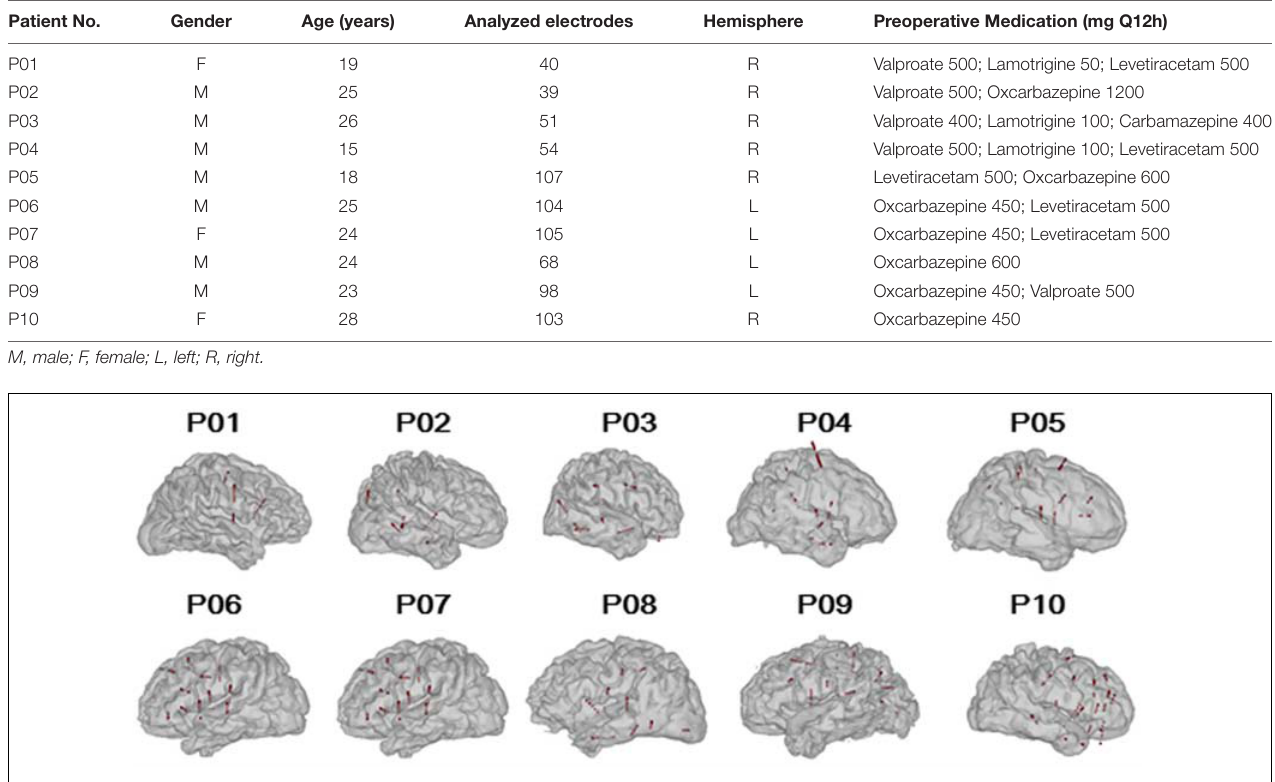
FIGURE 1 | Reconstructed participant-specific brain models and locations of implanted electrodes. The black lines represent the paths of the depth electrodes and the red spheres represent the valid nodes ( n = 769).